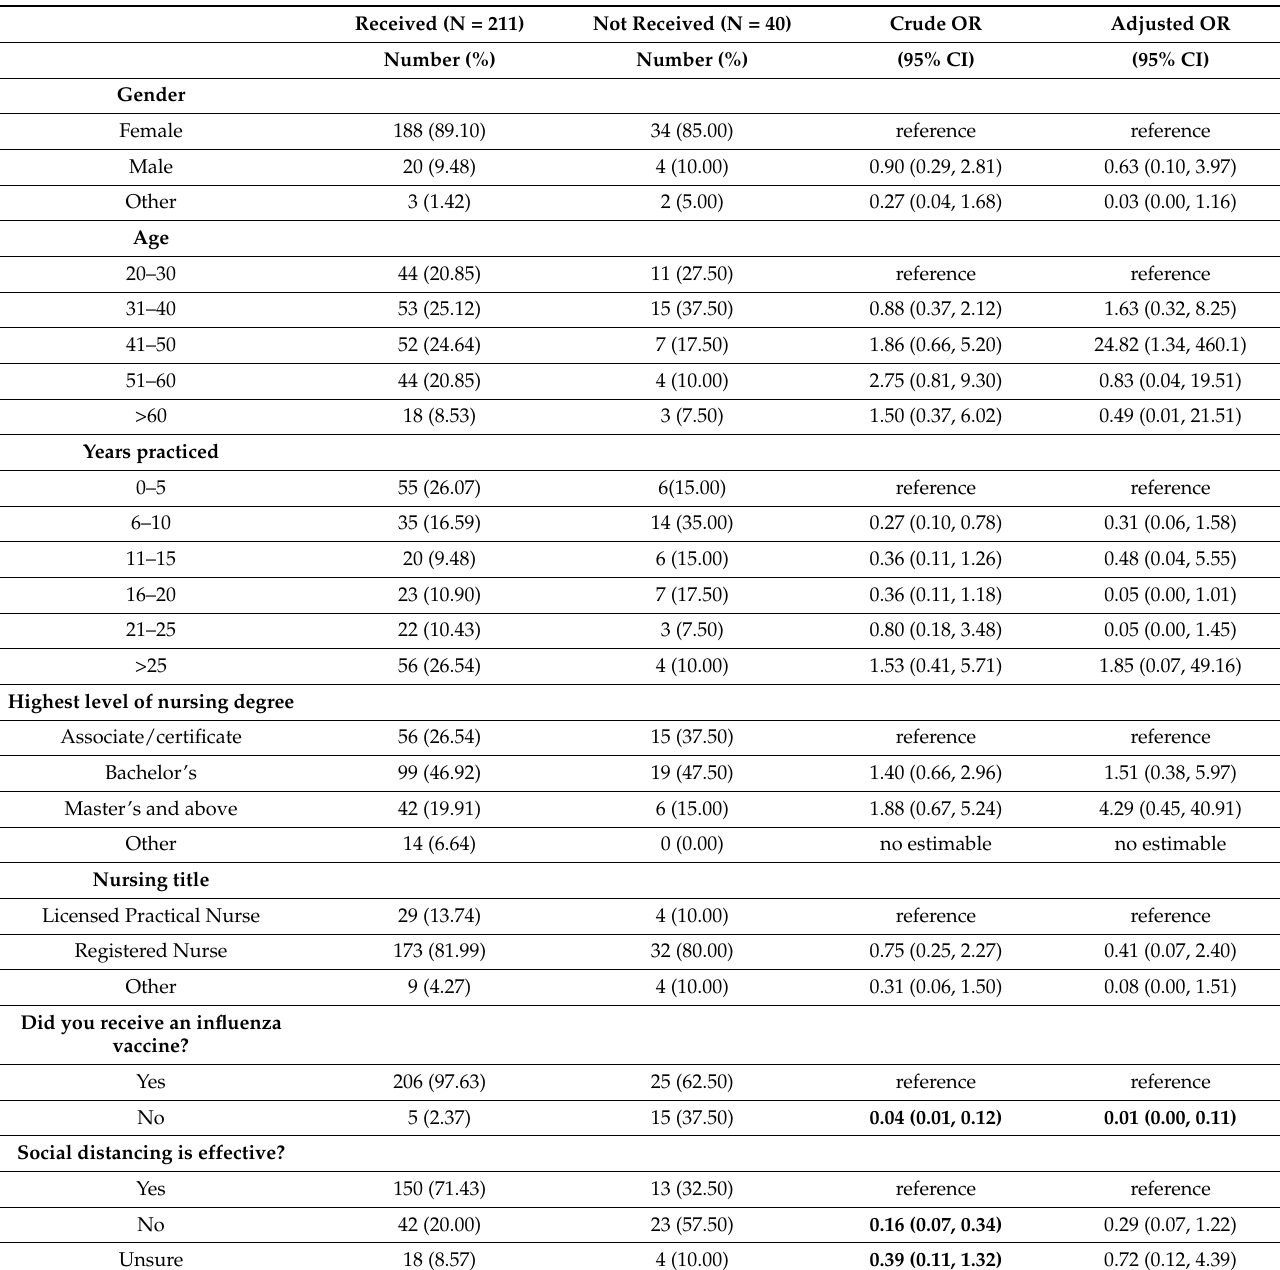
Table 3. Vaccination rates and nurse